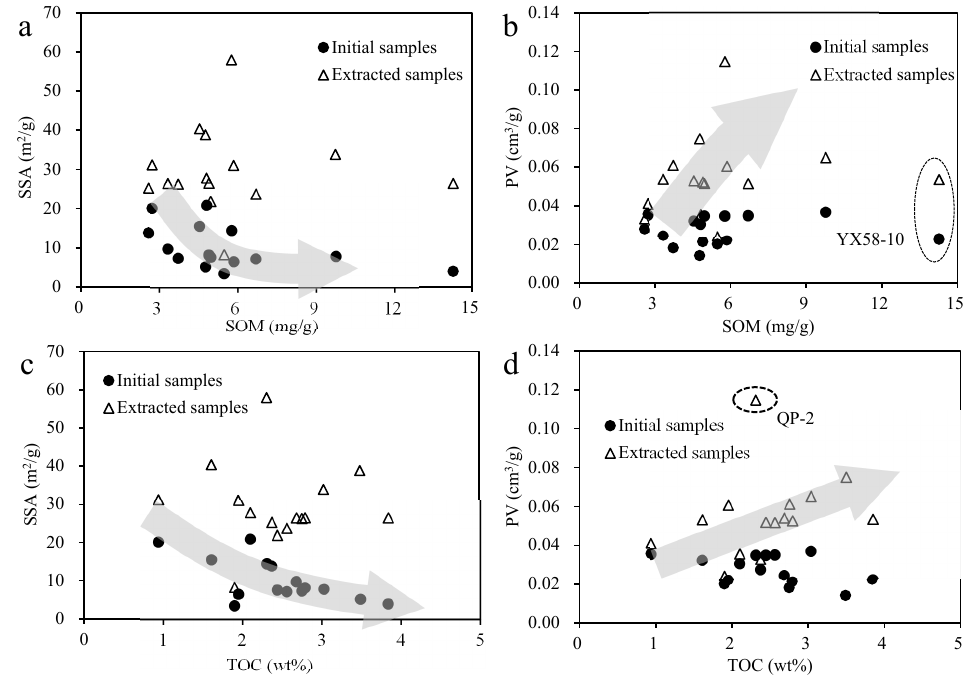
Figure 8. Correlation between the OM compositions and pore structure parameters. ( a ) SOM vs. SSA; ( b ) SOM vs. PV; ( c ) TOC vs. SSA; ( d ) TOC vs. PV.